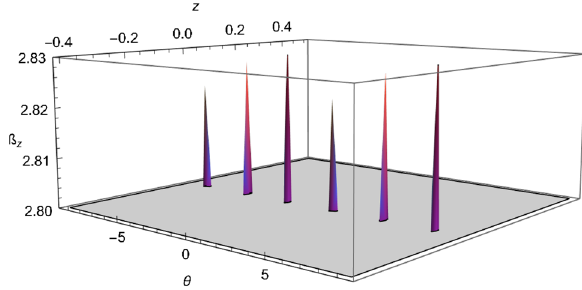
Figure 5. Inset of Fig. 3, for the values of B z from 2.80 to